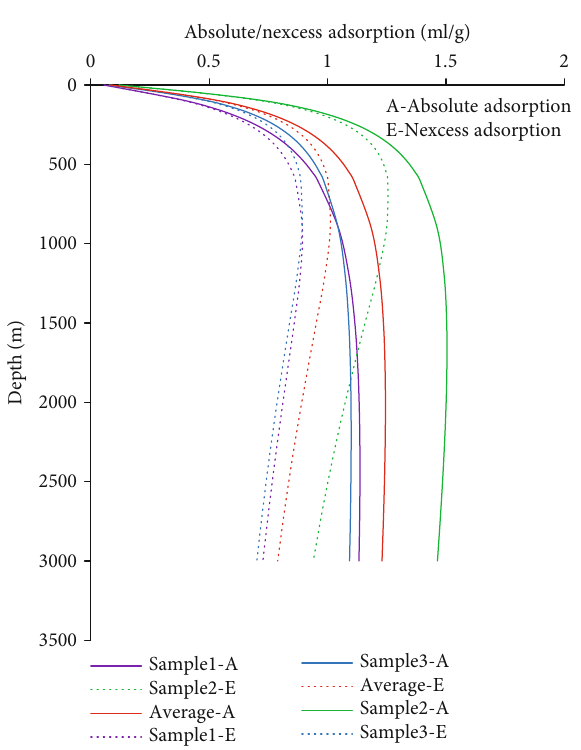
Figure 6: Methane adsorption capacity of original rocks in three samples under geological conditions.